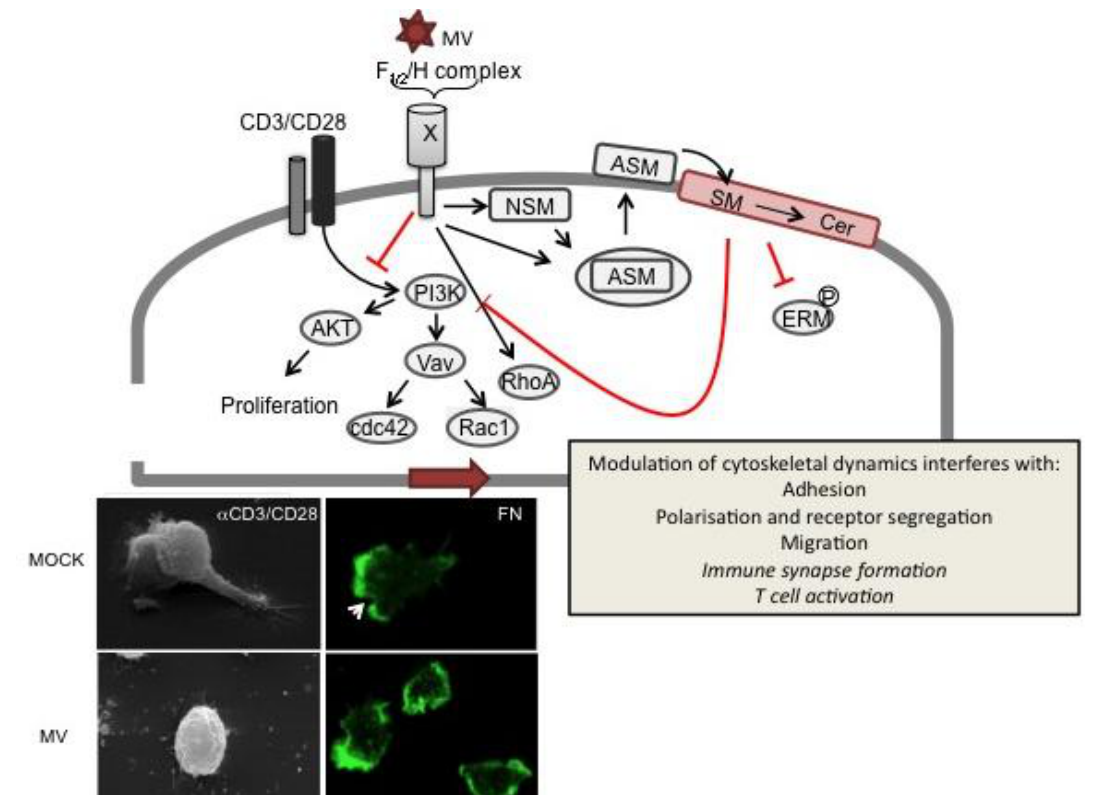
Figure 3. MV signaling via receptorX causes T cell actin cytoskeletal paralysis. On binding to recX, the MV gp complex (consisting of the proteolytically activated F heterodimer and the H protein) signals to abrogate PI3K activation, e.g., in response to TCR ligation (CD3/CD28), which causes inactivation of downstream effectors such as Akt kinase, Vav and Rac1/Cdc42. To a major extent, PI3K interference is mediated by sequential activation of neutral (NSM) and acid sphingomyelinase (ASM), which promotes surface translocation of ASM and subsequent breakdown of outer membrane sphingomyelin (SM) and formation of ceramide (Cer)-enriched membrane microdomains. ASM activation and ceramide accumulation have been linked to abrogation of ERM phosphorylation, RhoA activation and PI3K interference and loss of actin based protrusions in non-lymphoid cells. In T cells, ceramide induction by MV or recombinant bacterial sphingomyelinase has been directly linked to the MV (bottom panels) loss of actin cytoskeletal dynamics as evidenced by loss of actin and receptor polarization, microvillar protrusions or lamellopodial structures on substrates mimicking the ECM (such as fibronectin, bottom right panels, where actin is detected by phalloidin (green), the arrow marks the leading edge in MOCK treated cells) or the immunological synapse (  CD3/CD28 coated slides, bottom left panels; the upper panel shows two interacting MOCK treated T cells). Whether ceramide accumulation also directly accounts for MV-dependent inhibition of IS formation or T cell activation is as yet unknown (therefore indicated in